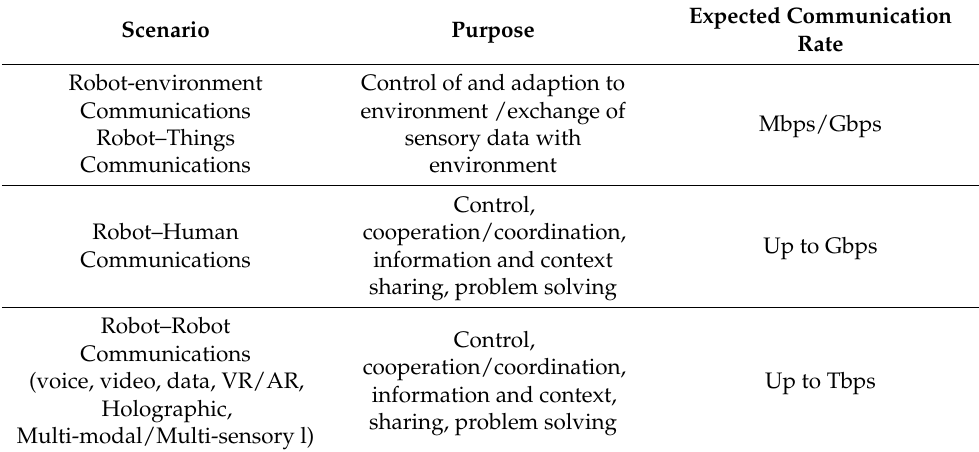
Table 2. Future scenarios and communication requirements of robotic